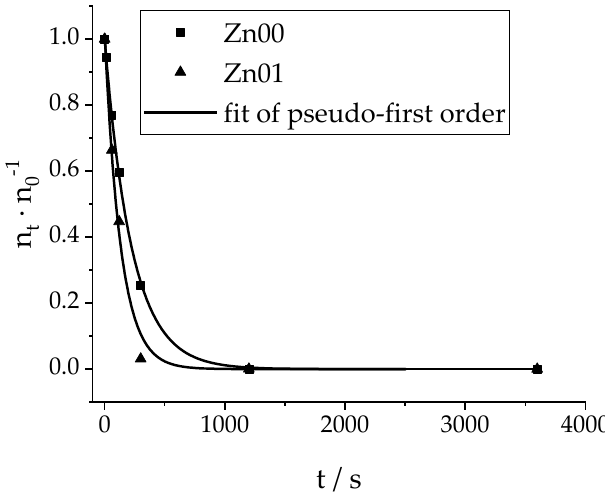
Figure 3. Reaction monitoring of the photocatalytic degradation of EE2 with porous titanium dioxide catalysts; the number in the catalyst’s name (Zn25) indicates the nominal amount of zinc in comparison to the amount of titanium used for synthesis in mol-percent; Zn00 resembles pure TiO 2 ; each point resembles an individual formulation, n t speaks of the ion count after the irradiation time t, n 0 indicates the ion count without irradiation after dormant phase; the ion count is a measure of the concentration c (see the calibration curve in Figure 1); functional fit of pseudo-first order: k Zn00 = 0.0044 s − 1 , k Zn01 = 0.0075 s − 1 .